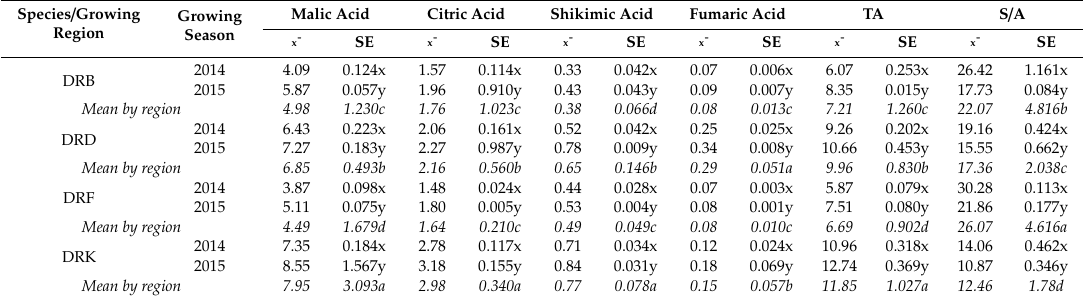
Table 4. Average content of individual organic acids, total acids (TA) and sugars / acids ratio (S / A) in analyzed wild fruit species (g kg − 1 FM) *. Table 3. Average content of individual sugars, total sugars (TS) and glucose/fructose ratio (G/F) ± SE Table 3. Average content of individual sugars, total sugars (TS) and glucose/fructose ratio (G/F) ± SE Table 3. Average content of individual sugars, total sugars (TS) and glucose/fructose ratio (G/F) ± SE Table 3. Average content of individual sugars, total sugars (TS) and glucose/fructose ratio (G/F) ± SE Table 3. Average content of individual sugars, total sugars (TS) and glucose/fructose ratio (G/F) ± SE Table 3. Average content of individual sugars, total sugars (TS) and glucose/fructose ratio (G/F) ± SE in analyzed wild fruit species (g kg − 1 FM (fresh mass))*. in analyzed wild fruit species (g kg − 1 FM (fresh mass))*. in analyzed wild fruit species (g kg − 1 FM (fresh mass))*. in analyzed wild fruit species (g kg − 1 FM (fresh mass))*. in analyzed wild fruit species (g kg − 1 FM (fresh mass))*. in analyzed wild fruit species (g kg − 1 FM (fresh